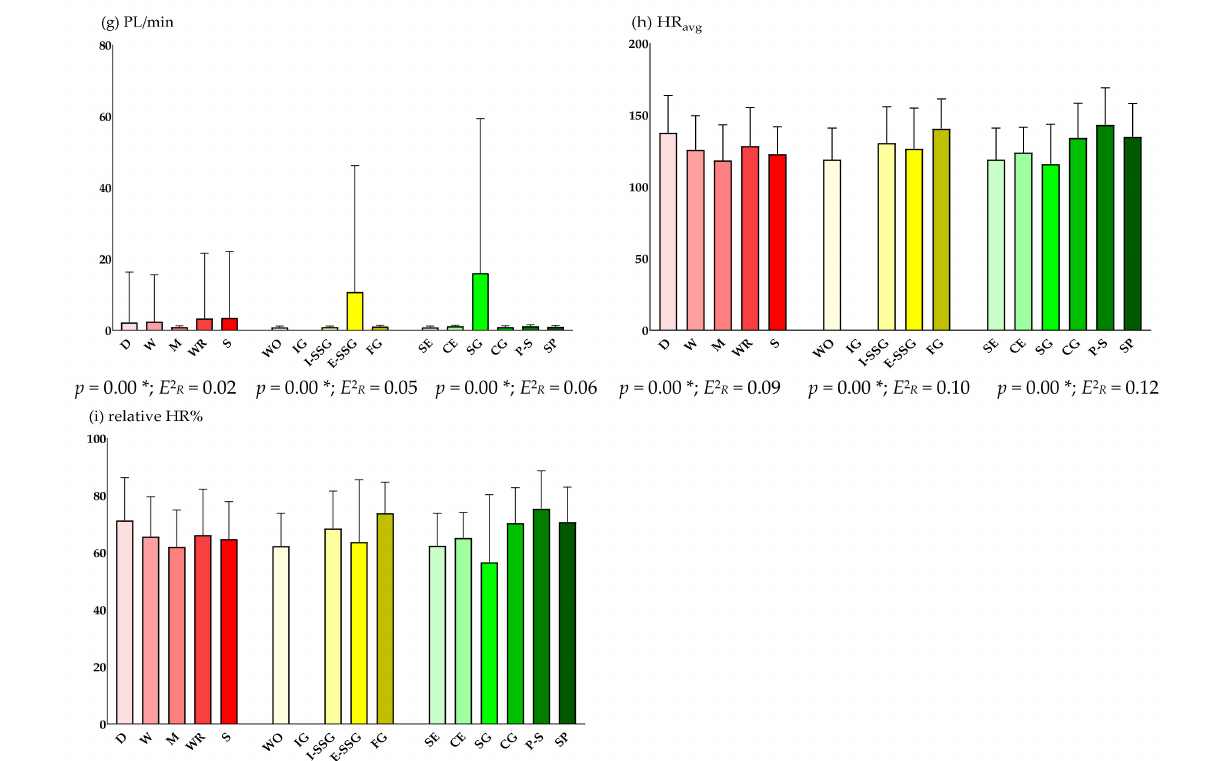
Figure 2. Descriptive and inferential results of the training sessions according to the specific player